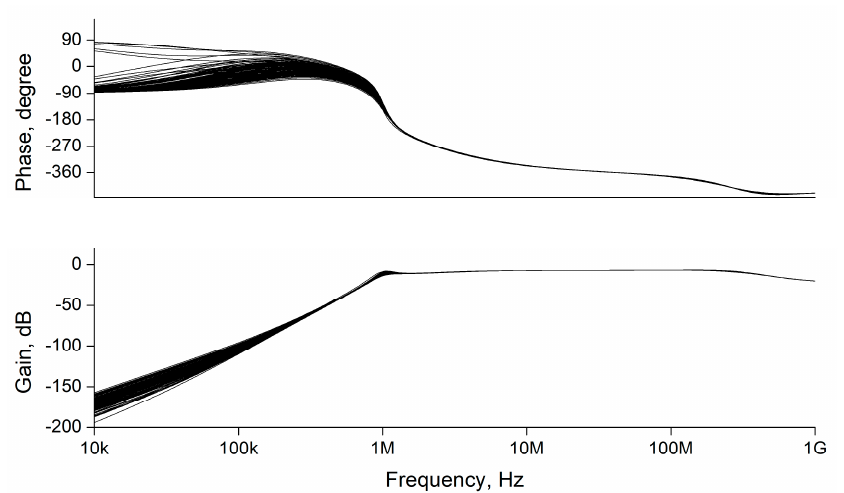
Figure 14. Monte Carlo simulations of the HP ladder filter with changes of threshold voltages of all the MOS transistors.